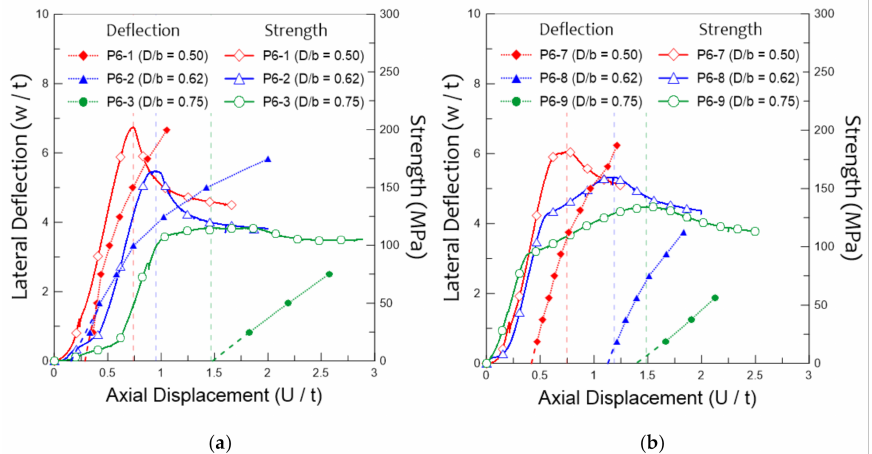
Figure 12. Relationship between force and lateral deflection of perforated plates: ( a ) 66.6 (b/t) and ( b ) 50